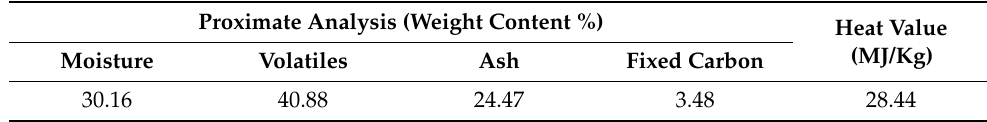
Table 3. Heavy metal content of oily sludge.